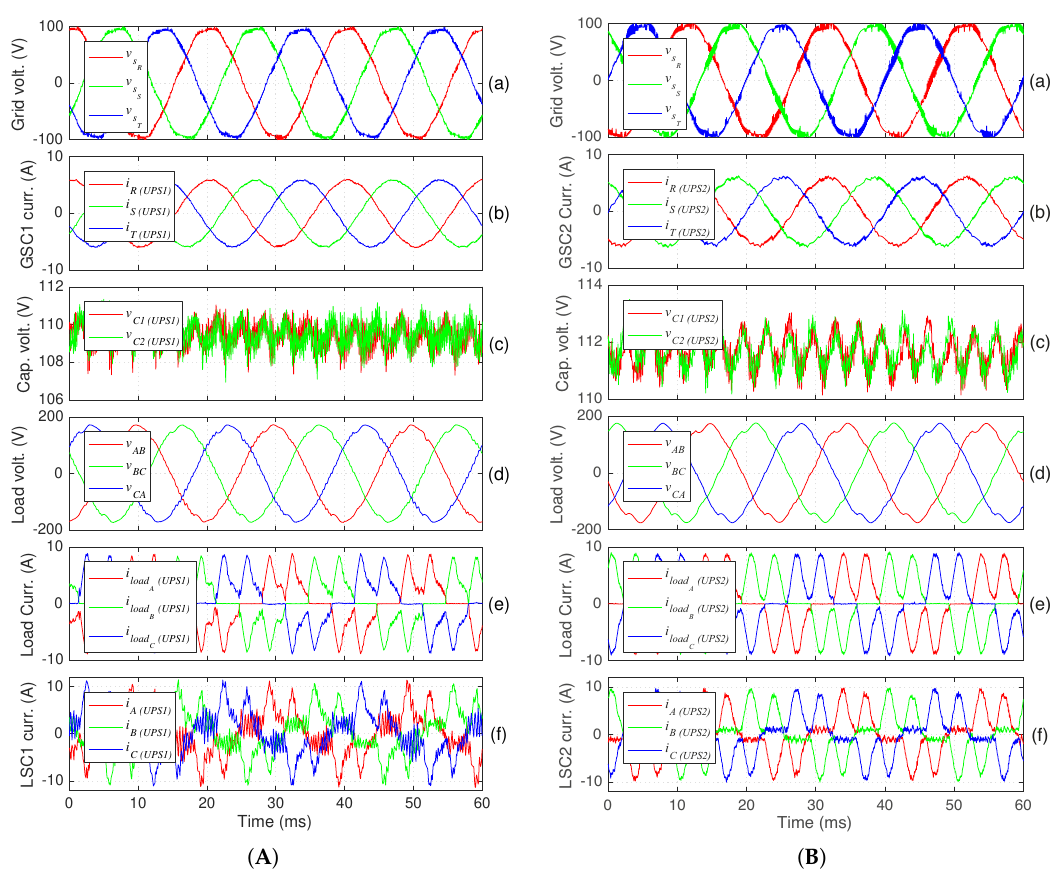
Figure 9. Individual UPS systems performance supplying the non-linear load: ( A ) UPS1 operation; ( B ) UPS2